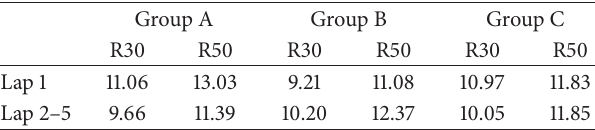
Table 4: The speed of two